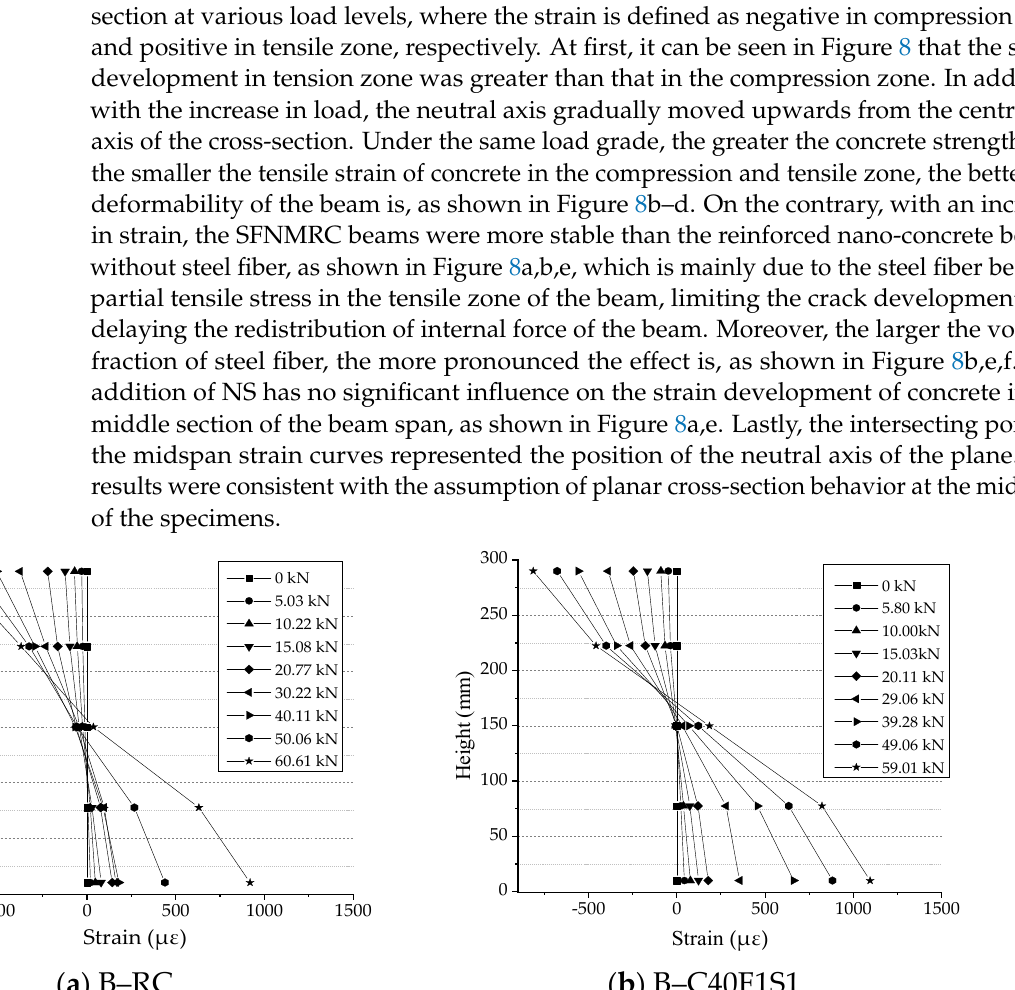
Figure 7. Cracking load of all the tested specimens.